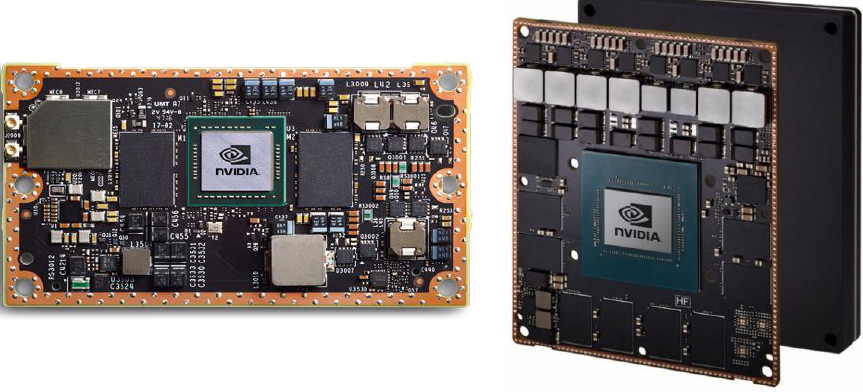
Figure 21. The Jetson TX2 module (credit card size) ( left ) and Jetson AGX Xavier ( right ).